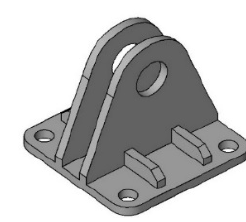
Figure 8. Components based in C-shaped steel beam.